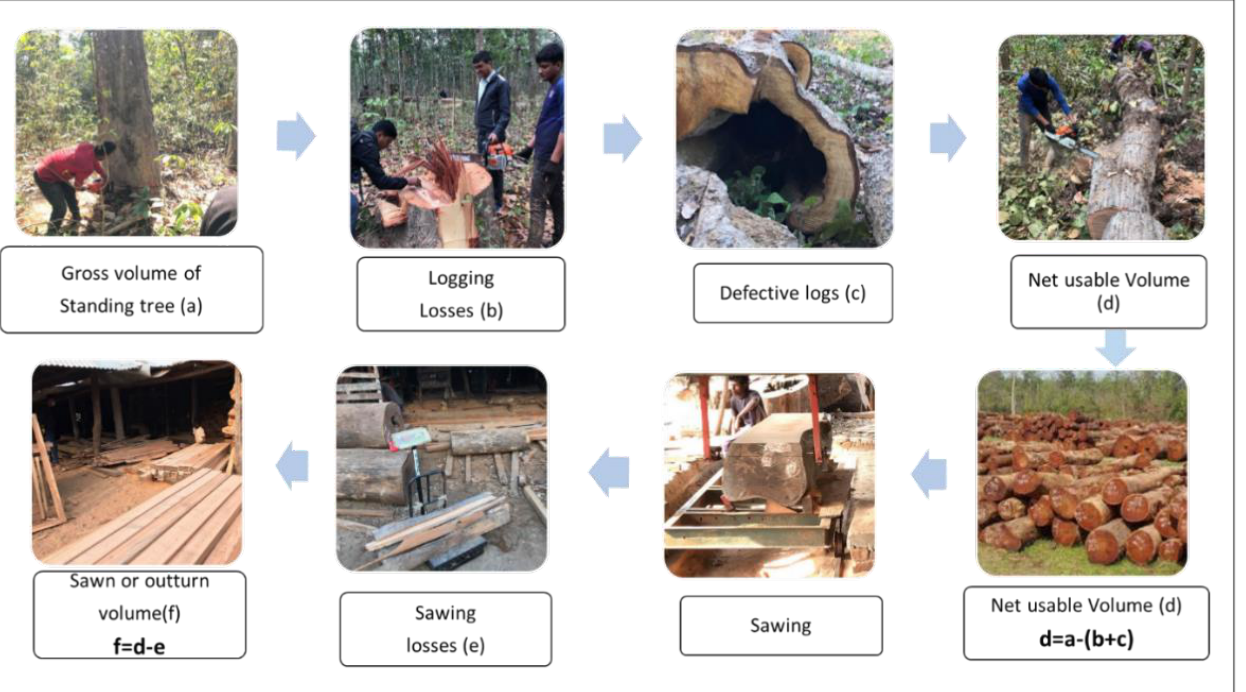
Figure 2. A schematic overview of research framework showing harvesting flow from standing tree to final outturn.